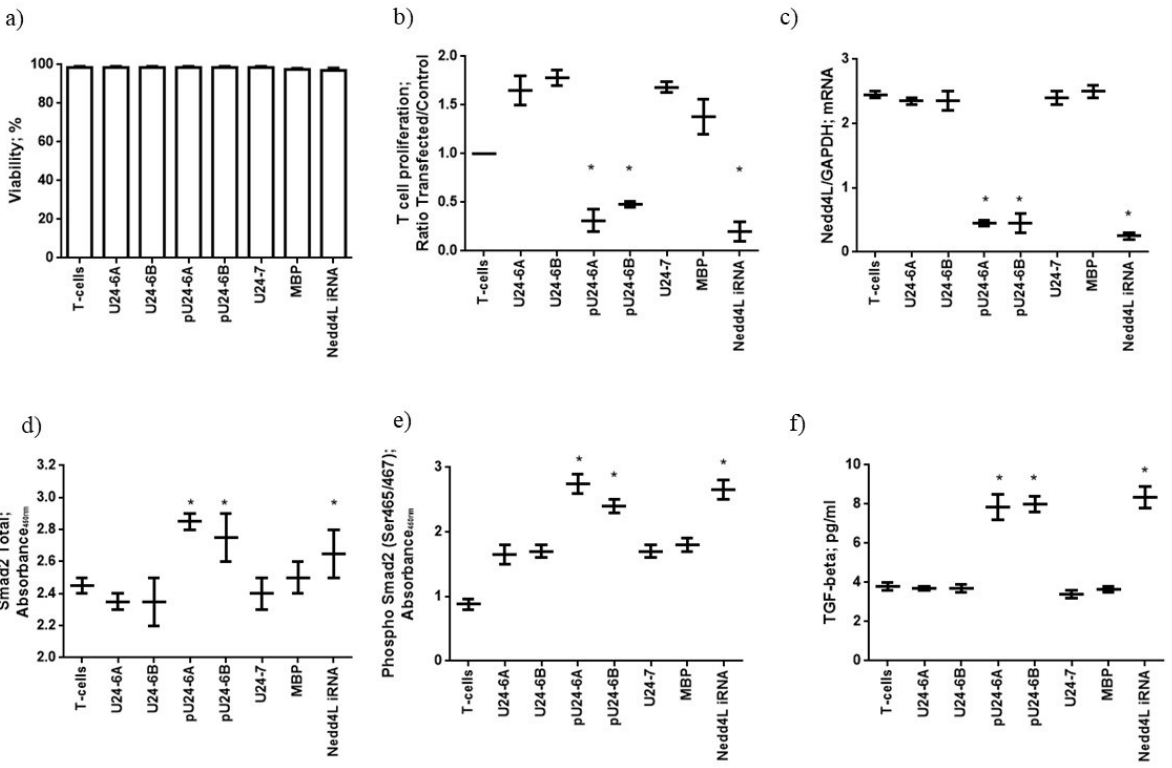
Figure 2. ( a ) T cells from 12 MS patients were purified and transfected with the transfection reagent alone (T cells) the peptides U24-6A, U24-6B, pU24-6A, pU24-6B, MBP or U24-7 or Nedd4L iRNA. T-cell viability was evaluated using a lactate dehydrogenase (LDH) assay. ( b ) T-cell proliferation was evaluated using an EdU assay. ( c ) Levels of Nedd4L mRNA in comparison with GAPDH mRNA levels. Levels of ( d ) total Smad2 and ( e ) phosphorylated Smad2 and ( f ) TGF-β1, performed by ELISA assay. The values are reported as mean ± SD. * significant p value < 0.05, one way ANOVA for multiple comparison corrected for multiple comparisons, by Bonferroni’s correction. iRNA: RNA-mediated knockdown of Nedd4L.